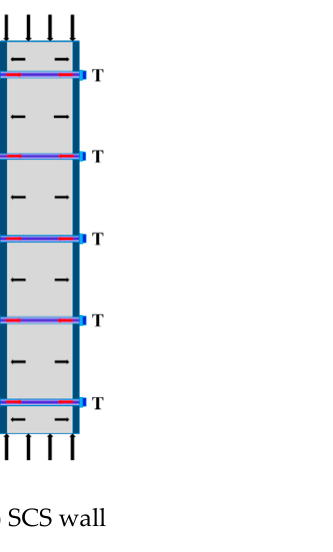
Figure 4. The force transmission of the two-composite wall.